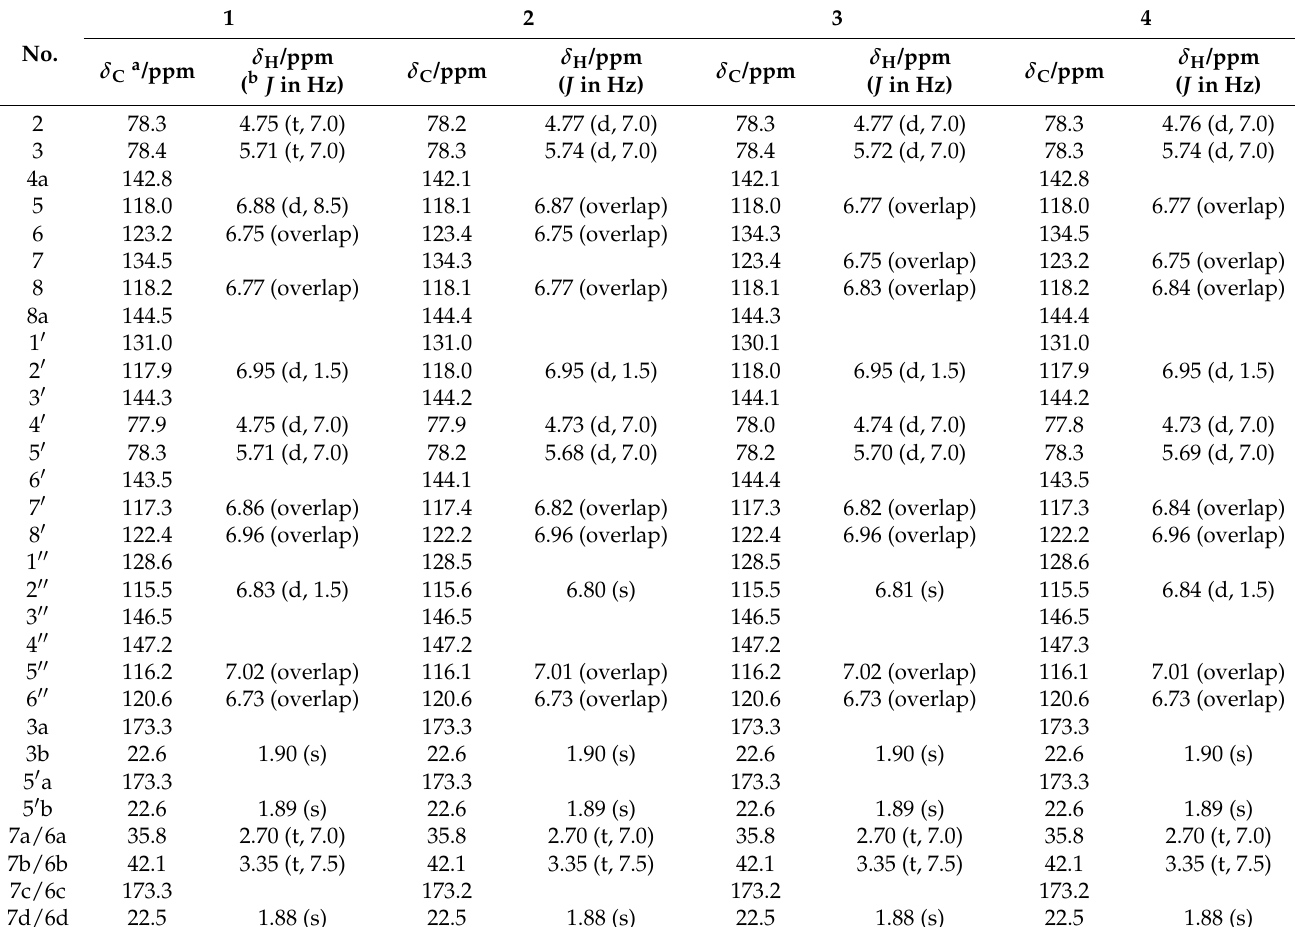
Table 1. 1 H-NMR and 13 C-NMR Data of Compounds 1 , 2 , 3 , and 4 .